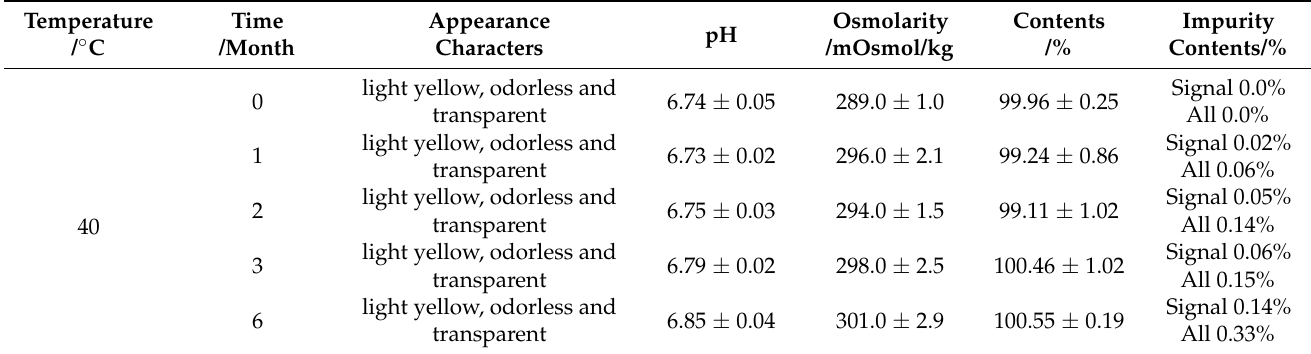
Table 4. Accelerated stability of BR-ISG ( n =